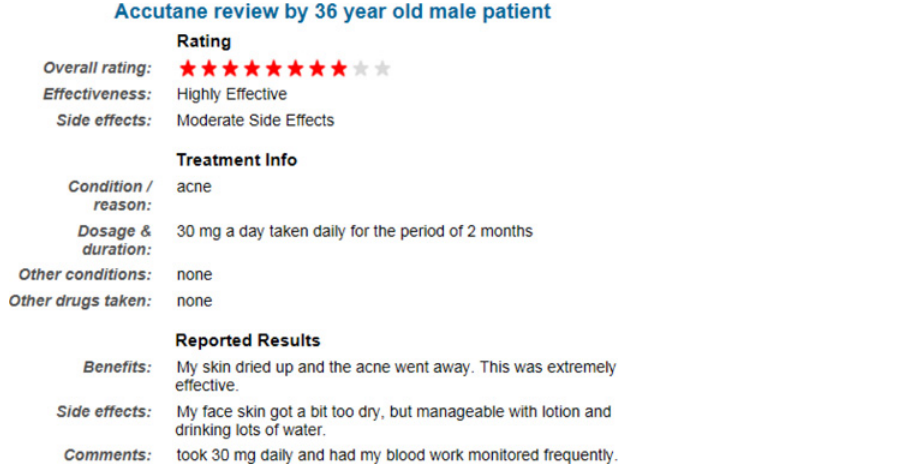
Fig 4. An example of a structured review from